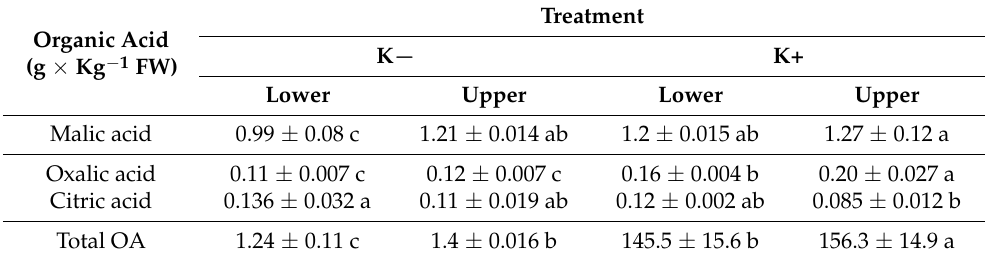
145.5 ± 15.6 b 156.3 ± 14.9 a Means ± standard errors (SE) are shown. Statistically significant differences between treatments for each canopy zone are represented by different lowercase letters (horizontally), based on the LSD Fisher multiple range test ( p ≤ 0.05 ).